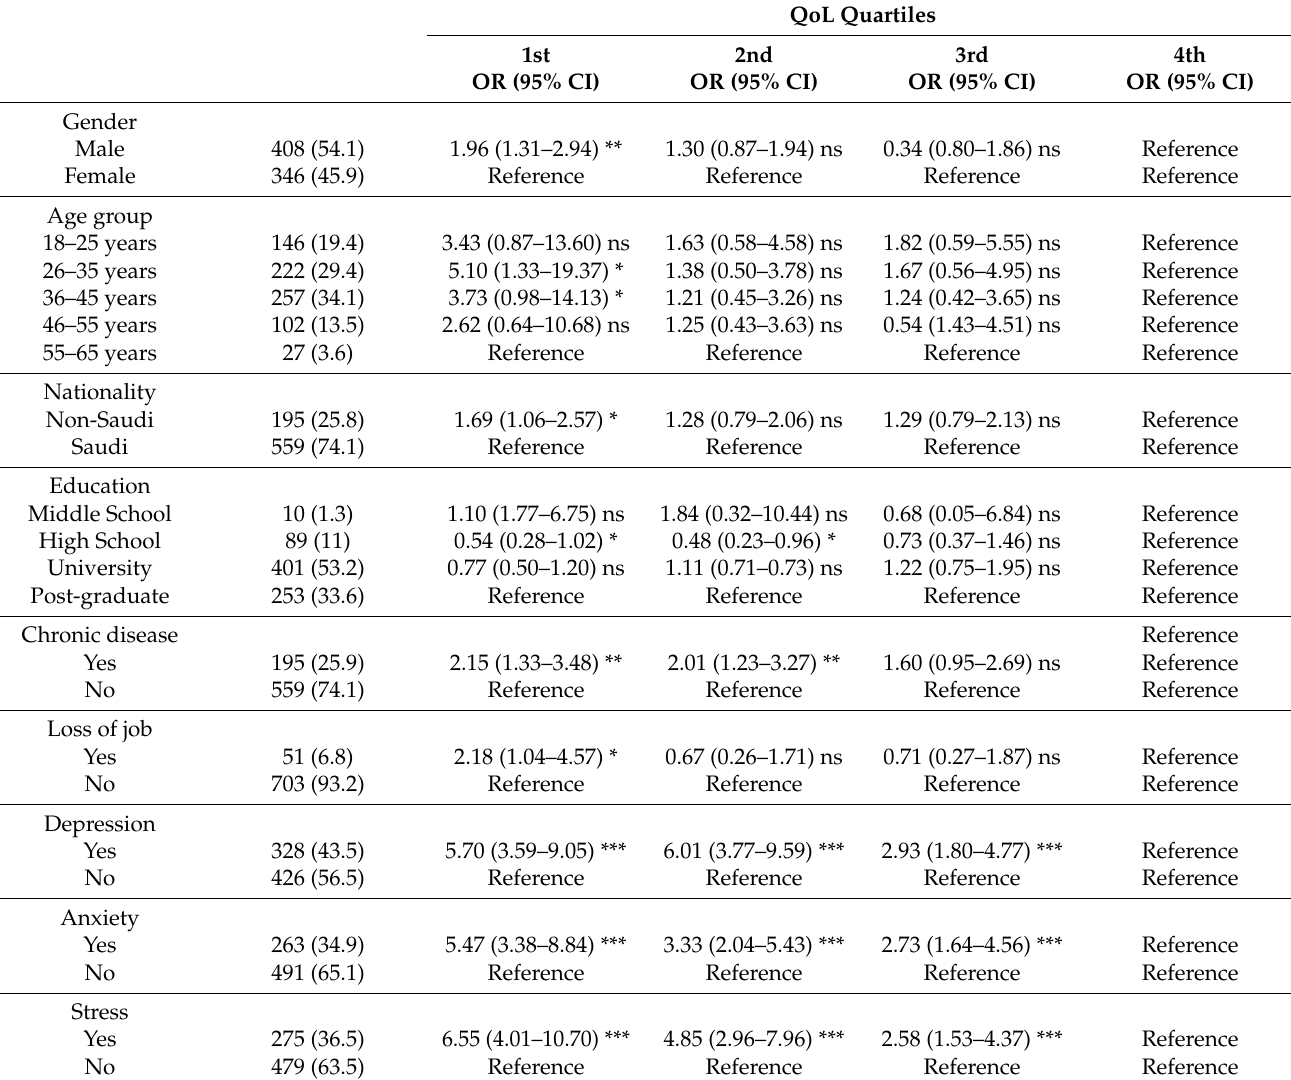
Table 2. The multinomial regression between the QoL score quartiles and associated factors in the KSA during the COVID-19